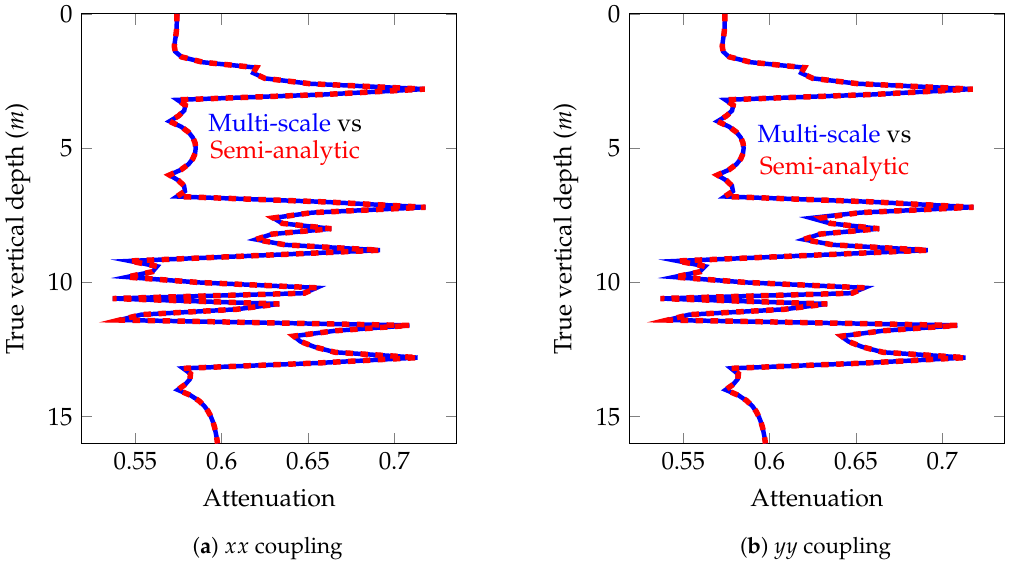
Figure 12. Model problem 2. Attenuations for the non-zero couplings ( xx and yy couplings) of the magnetic field for a vertical well (dip angle = 0 ◦